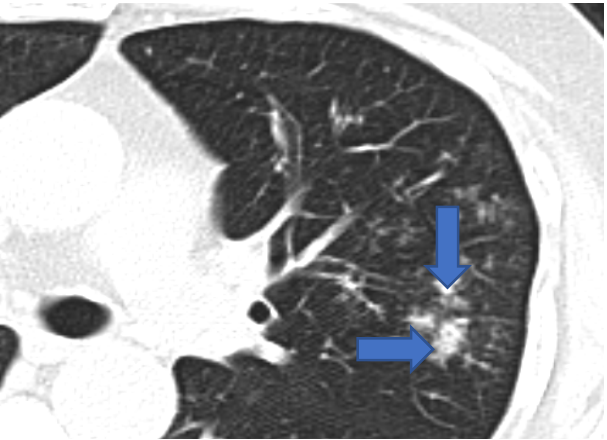
Figure 2. CT scan of the same patient showing a pleural-based consolidation with central clearing (blue arrow) and surrounding, denser, consolidation typical of reverse halo sign; also seen in left mild pleural effusion.